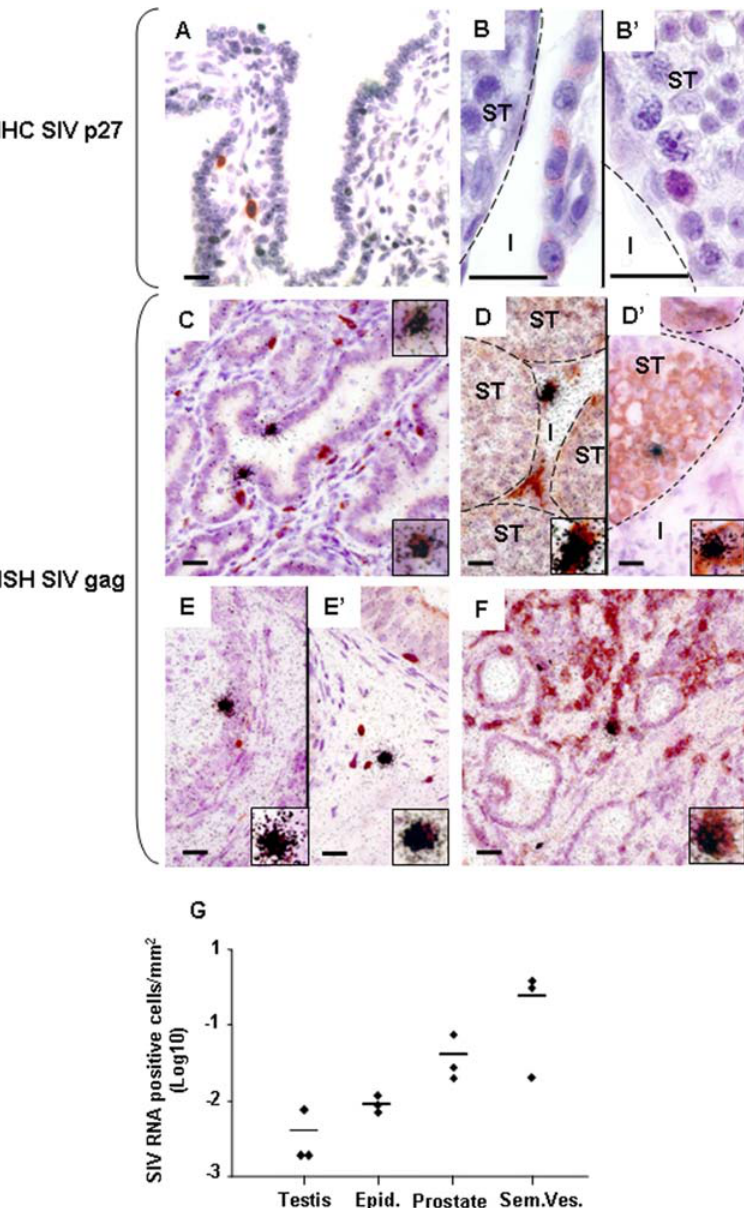
Figure 4. SIV localization within the male genital tract. Detection of SIV positive cells in the seminal vesicles (A, C), testes (B–B’, D–D’), epididymides (E, E’) and prostate (F) of primary-infected macaques using immunohistochemistry for SIVp27 (A, B) and in situ hybridization (ISH) for SIV gag RNA (C–F). The phenotype of SIV positive cells was determined using ISH for SIV gag RNA (visualized as black silver grains) combined with immunostaining for cell markers (visualized as brown staining): combined ISH for viral RNA and immunostaining for CD3 revealed black silver grains clustered over brown cells in the seminal vesicles (C), prostate (F), and epididymis (E’), indicating infection of CD3 + T lymphocytes. Co-labelling of SIV RNA + cells with the myeloid cell marker CD68 was also observed, as shown here for the epididymis (E). In the testis, SIV RNA was detected within the interstitium in HLA-DR + cells (D) and within the seminiferous tubules in VASA + germ cells (D’). Inserts show enlargement of SIV RNA positive cells co- stained for cell markers. I: testicular interstitium; ST: seminiferous tubules. Scale bars=20 m m. (G) SIV RNA + cells were counted in a minimum of 30 tissue sections/experiment in 3 independent experiments on a primary-infected macaque MGT. Results show the mean positive cell number/tissue area + / 2